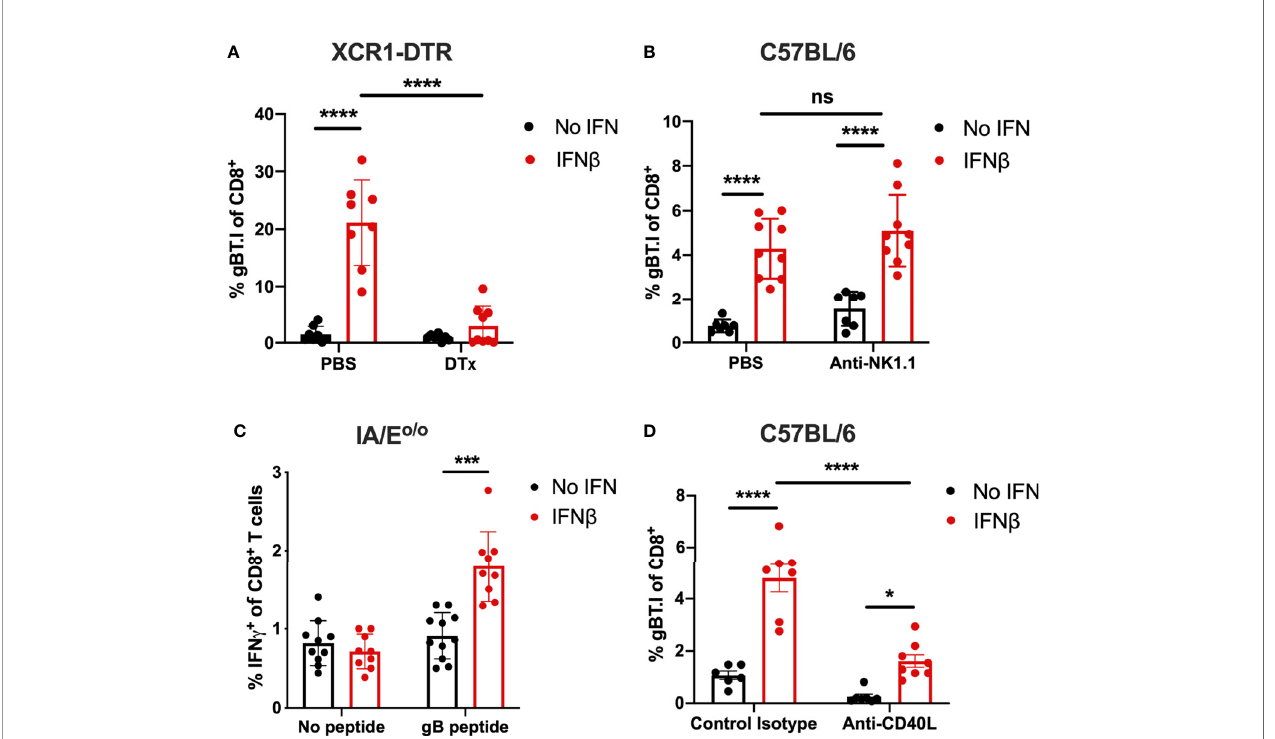
FIGURE 2 | IFN b -mediated expansion of gB-speci fi c CD8 + T cells is dependent on XCR1 + DCs, CD4 + T cells and CD40/CD40L signalling. Expansion of 5 x 10 4 transferred naïve gBT.I (A, B, D) or endogenous gB-speci fi c CD8 + T cells (C) was measured seven days post-vaccination with 2.5 x 10 6 irradiated B16.Kb loss .gB ± IFN b cells. (A) XCR1-DTR mice received either PBS control or 25 ng/g weight diphtheria toxin (DTx) one day prior to vaccination to deplete XCR1 + DCs (n = 8 per group). (B) C57BL/6 mice received control PBS or 200 µg anti-NK1.1 one day prior and post vaccination (n = 7-9 per group). (C) Splenocytes from IFN b -vaccinated IA/E o/o mice were restimulated with gB peptide and IFN g + endogenous CD8 + T cells were measured (n = 9-11 per group). (D) C57BL/6 mice received control isotype or 200 µg anti-CD40L on the same day as vaccination (n = 6-8 per group). Data is pooled from two independent repeats and analysed by one-way (C) or two-way (A, B, D) ANOVA, ****p < 0.001, ***p < 0.005, *p < 0.05, ns, not signi fi cant. Bars represent mean ±